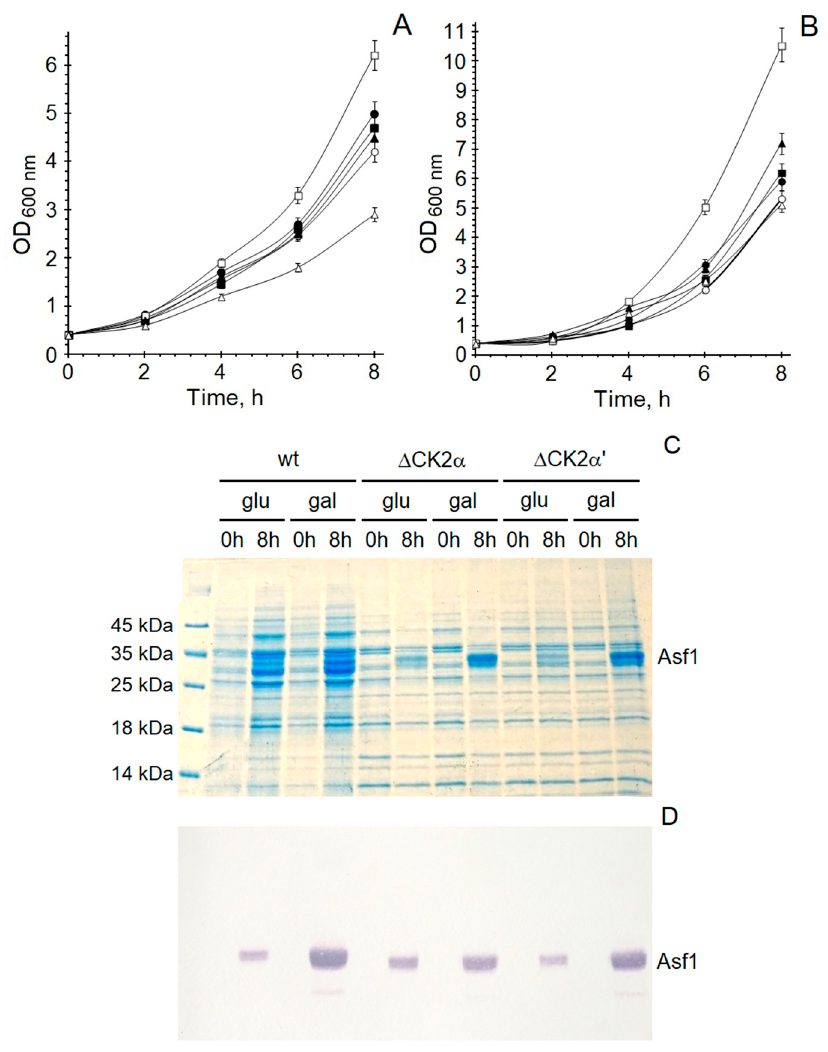
Figure 8. Influence of Asf1 protein towards yeast growth rate. ( A ) Medium containing galactose, ( B ) medium containing glucose. Optical densities determined after 0–8 h for cultures S. cerevisiae wt ( ● ), S. cerevisiae wt/pYES2/CT:: Asf1 ( ○ ), S. cerevisiae Δ CK2 α ’ ( ■ ), S. cerevisiae Δ CK2 α ’/pYES2/CT:: Asf1 ( □ ), S. cerevisiae Δ CK2 α ( ▲ ), and S. cerevisiae Δ CK2 α /pYES2/CT:: Asf1 ( ∆ ). ( C ) SDS/PAGE of lysates from 8 h cultures and ( D ) Western blot analysis of lysates from 8 h cultures.